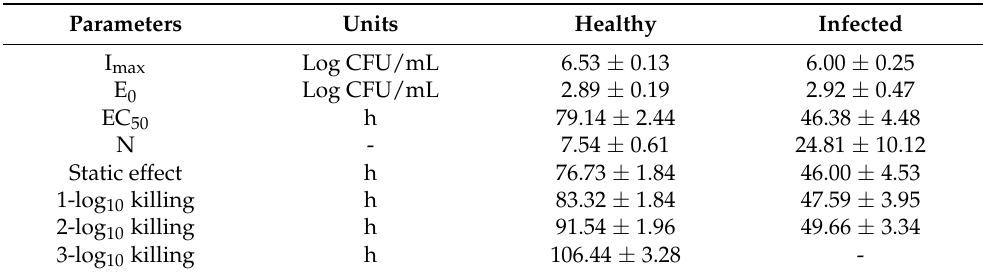
Table 4. The PK/PD modeling of cefquinome in plasma at a dose of 2 mg/kg by intramuscular injection of the pigs.